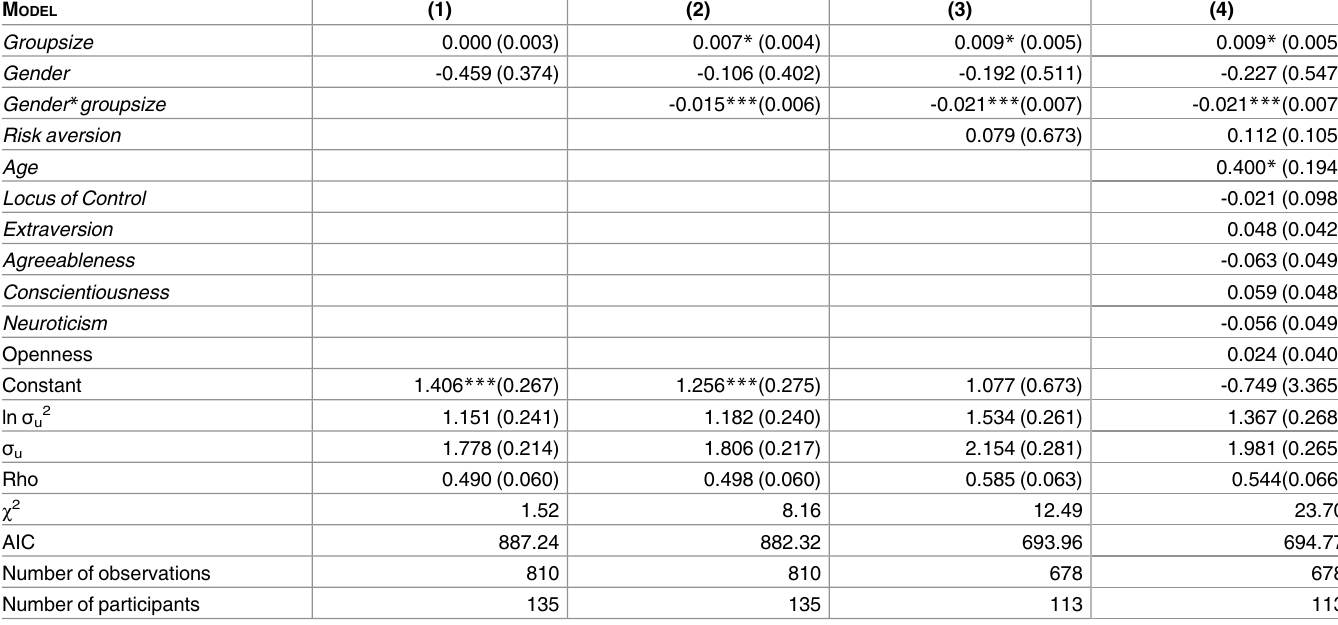
Table 4. Random effectslogistic